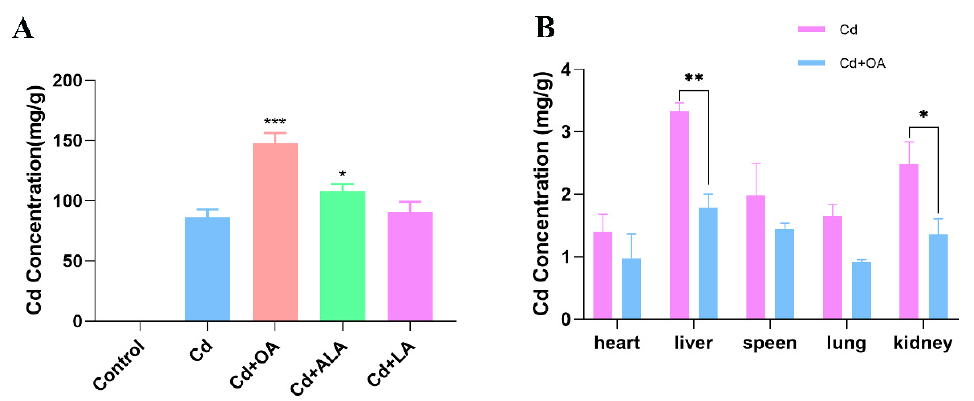
Figure 1. Effects of different fatty acids on the Cd contents in Cd-exposed mice. ( A ) The Cd contents in feces of Cd-exposed mice treated with three kinds of fatty acids for 7 days. ( B ) The Cd contents in different organs of Cd-exposed mice treated with OA. * p < 0.05, ** p < 0.01, and *** p < 0.001 versus the Cd group.